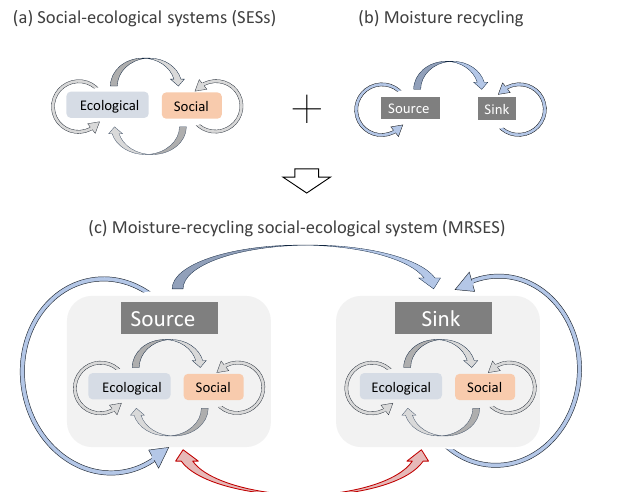
Figure 1. Conceptual construction of moisture-recycling social ecological system (MRSES) archetypes. A hypothetical, idealized social–ecological system (a) is nested within the idealized moisture- recycling system (b) , creating a linked moisture-recycling social– ecological system (c) . The red arrow at the bottom of (c) emphasizes the fact that the social aspects of a MRSES are what link the pre- cipitation sink back to its evaporation sources. The arrow points in both directions, since social links are not restricted by biophysical